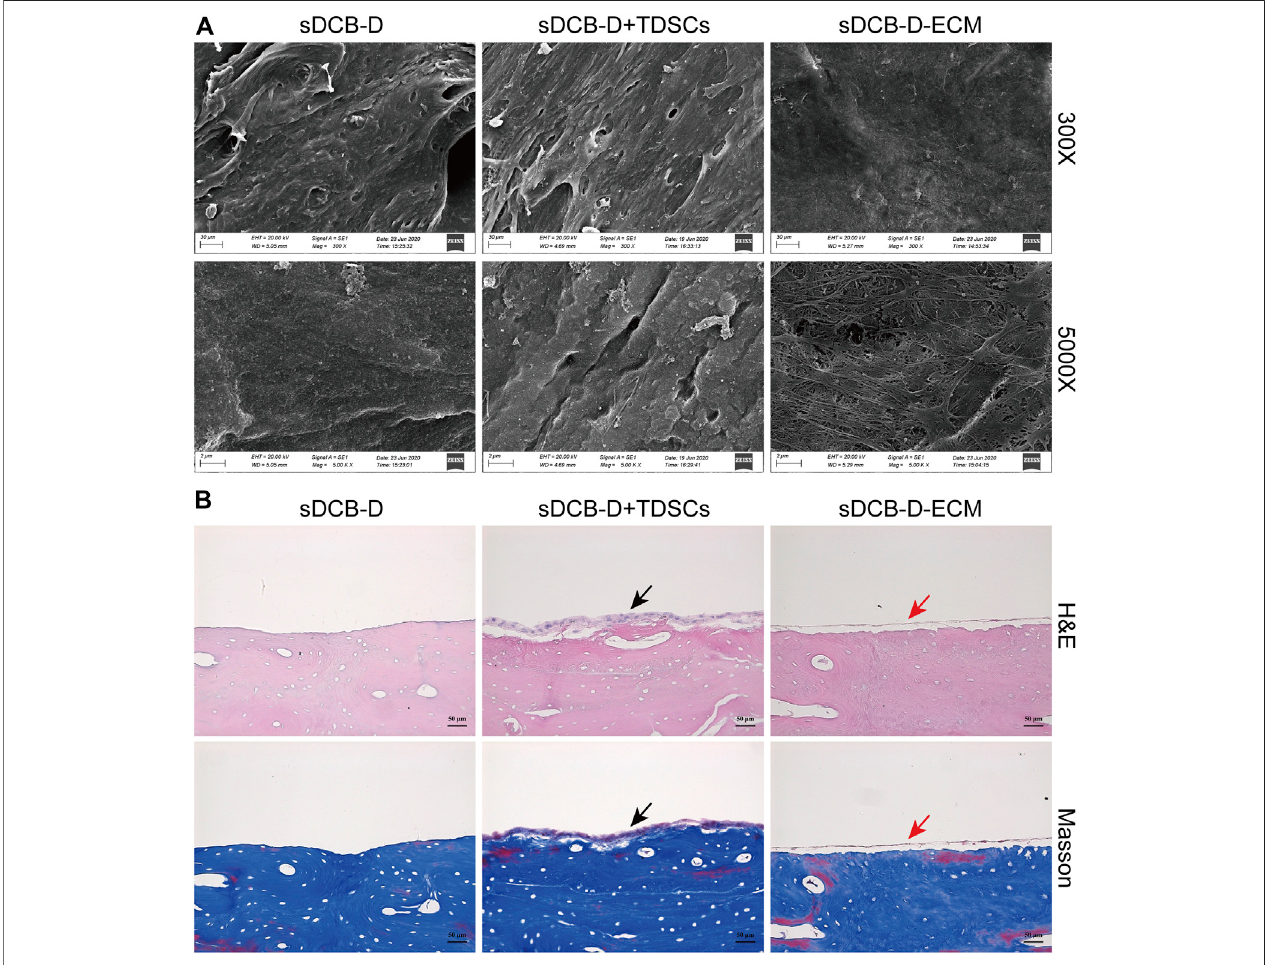
FIGURE 3 | (A) SEM images of sDCB-D (left panels), sDCB-D with TDSCs (middle panels) and sDCB-D-ECM (right panels). Scale bar (cid:1) 30 μ m at × 300 magni fi cation; Scale bar (cid:1) 2 μ m at × 5,000 magni fi cation. (B) Histological staining ofsDCB-D (left panels), sDCB-D with TDSCs (middle panels) and sDCB-D-ECM (right panels). Black arrows indicated seeded stem cells; red arrows indicated stem cell-derived ECM. Scale bar (cid:1) 50 μ